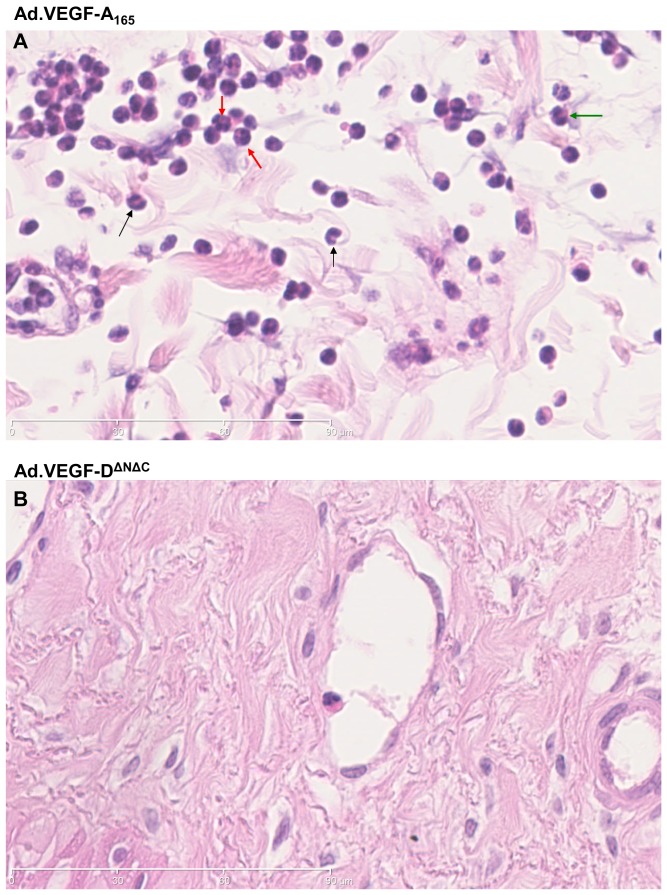
Representative H&E stained pictures of uterine artery sections treated with (A) Ad.VEGF-A165 or (B) Ad.VEGF-DΔNΔC.The arrows point towards leucocytes which leak into the adventitia due to enhanced permeability on account of VEGF-A165 over-expression. The black arrows point towards monocytes (horse-shoe shaped nuclei); red arrows towards neutrophils (polymorphic nuclei) and green arrow towards basophils (bilobed nuclei).